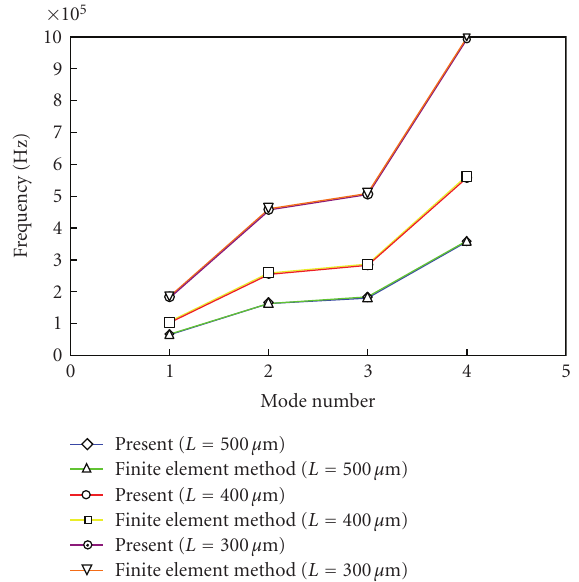
Figure 3: Frequencies of an electrostatic fixed-fixed actuator for various beam lengths.